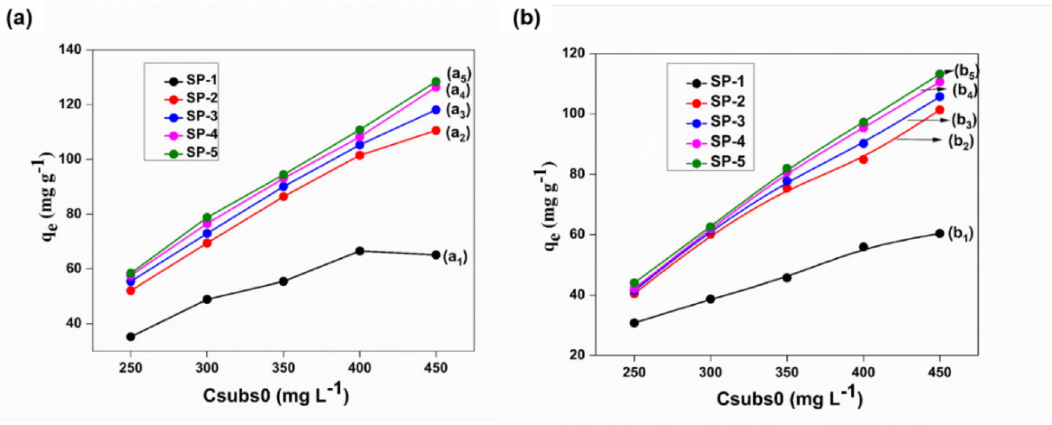
Figure 5. The adsorption capacity of initial concentration of ( a ) Cd(II), and ( b ) Pb(II) by SP-1 and SP-2, 3, 4, 5 The effect of pH on heavy metal absorption by SP-5 ENMs could be explained in terms of pHpzc of the adsorbent in the solution (pHpzc = 7.2, Fig. 4c), as Cd(II), Pb(II) adsorption would be facilitated by electrostatic interaction between positively charged Cd(II), Pb(II) species (H 2 CdO 3 − and H 2 PbO 3 − are predominant in the experimental pH range) and negatively charged absorbent surface, are shown in Fig. 4c. In this case, the higher removal efficiency was due to the abundant protonation of the adsorption sites on SP-5 ENMs, which interacted with positively charged metal ions species at pH < pHpzc. With the increasing pH, the net surface charge on the adsorbent became less positive and even negative, and repulsive forces between cations adsorbate and adsorbent resulted in a decrease of the Cd(II), Pb(II) adsorption capacity 43,45 . Effect of initial concentration. The effect of the initial concentration of Cd(II) and Pb(II) ions on the binding capacities of the SP-1 and SP-2, 3, 4, 5 ENMs are shown in Fig. 5. For the EUOL@AgNPs-SP-ENMs, adsorp- tion capacity rapidly increased with an increase in initial concentration of Cd(II) and Pb(II) , whereas, for SP-1 ENMs, the ENMs was saturated with Cd(II) and Pb(II) at Csubs0 of 400 mg L −1 as the adsorption reached a plateau but for SP-5 ENMs, the Cd(II) and Pb(II) binding capacity was still increasing. As shown in Fig. 5a, the Cd binding of 128.4 mg g −1 was achieved for the SP-5 ENMs compared to the SP-1 ENMs, which showed the Cd(II) binding capacity of 65.1 mg g −1 at the initial concentration of 450 mg L −1 . Similarly, the Pb(II) adsorption of 113.2 mg g −1 was achieved for the SP-5 ENMs compared to the 60.4 mg g −1 achieved for the SP-1 ENMs, which showed the Pb(II) binding capacity at the initial concentration of 450 mg L −1 , as shown in Fig. 5b. The addition of cationic EUOL@AgNPs to SP considerably enhanced the heavy metal binding capacity. It’s shown that increased adsorption capacity with the increasing of EUOL@AgNPs percentage. Adsorption kinetics. The Pb(II) and Cd(II) ions are toxic and typically found in contaminated surfaces and groundwater. These are very harmful to human health. Many scientists have paid a great deal of attention to the removal of Pb(II) and Cd(II) because of the severe Pb(II) and Cd(II) pollution in recent years. However, the adsorbent material needs to exhibit rapid and stable adsorption kinetics in removing heavy metal ions from the aqueous solution 45,66 . Therefore, in this experiment, the adsorption kinetic models were investigated by placing 25 mg of SP-1 and SP-2, 3, 4, 5 ENMs in a 10 mL solution of 250 µg mL −1 Pb(II), and Cd(II) concentration 66 . The effect of contact time (5–100 min) on the adsorption of Pb(II) and Cd(II) ions was investigated, as shown in Fig. 6. Adsorption of Cd(II) occurred rapidly and reached 80% at approximately 20 min; 100% equilibrium adsorp- tion was obtained in 40 min. By contrast, 80% of the adsorption of Pb(II) occurred comparatively slowly, and reached 100% equilibrium adsorption within 60 min. The mechanism is already explained previously in the pH 7 section. For SP-2, 3, 4, 5 ENMs the adsorption capacity progressed rapidly and almost reached equilibrium within 30 min. On the other hand, for the pure SP-1 ENMs, the adsorption capacity was lower, and equilibrium reached within 45 min, as shown in Fig. 6. The adsorption capacities increased gradually regardless of the Pb(II), and Cd(II) concentration. More than 90% of the total adsorption of Pb(II), and Cd(II) occurred within the first 60 min for SP-2, 3, 4, 5 ENMs, which was much higher than pure SP-1 ENMs. The adsorption behavior of SP-1 and SP-2, 3, 4, 5 ENMs for Pb(II) and Cd(II) ions is investigated, and adsorption kinetic data fitness is examined with two commonly used adsorption kinetic models. The Non-linear PFO model and PSO model were applied to describe the kinetic data comparison between SP-1 and SP-2, 3, 4, 5 ENMs, as shown in Fig. 6. Figure 6a, b illustrates that the non-linear PFO and PSO curve produces the best fitting results for both Pb(II) and Cd(II) ions. The PFO was found to be the most appropriate for describing the kinetic behaviour than the PSO model. But the value for the coefficient of determination (R 2 ) and adjusted coefficient of determination (R 2 adj ) (between 0.98 and 0.98) and the lowest values for the average relative error (ARE < 1.4%) are lower values for PFO than the PSO. The PFO model indicates that the adsorption mechanism